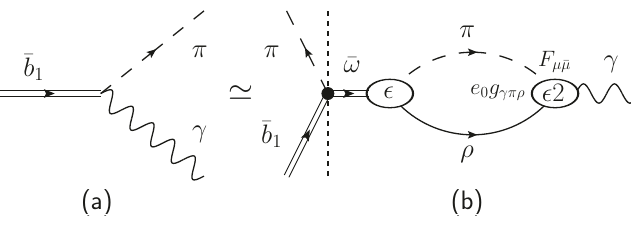
Figure 8 . (a) The ¯ b 1 πγ decay not through the ω (782) state (direct channel) and (b) phe- → nomenological description for the direct coupling between ¯ ω and γ . The vertex ‘ ǫ ’ and ‘ ǫ 2’ in (b) represent the anomalous hybrid state interpolation (4.20) and the physical interaction vertex given in eq. (5.1),